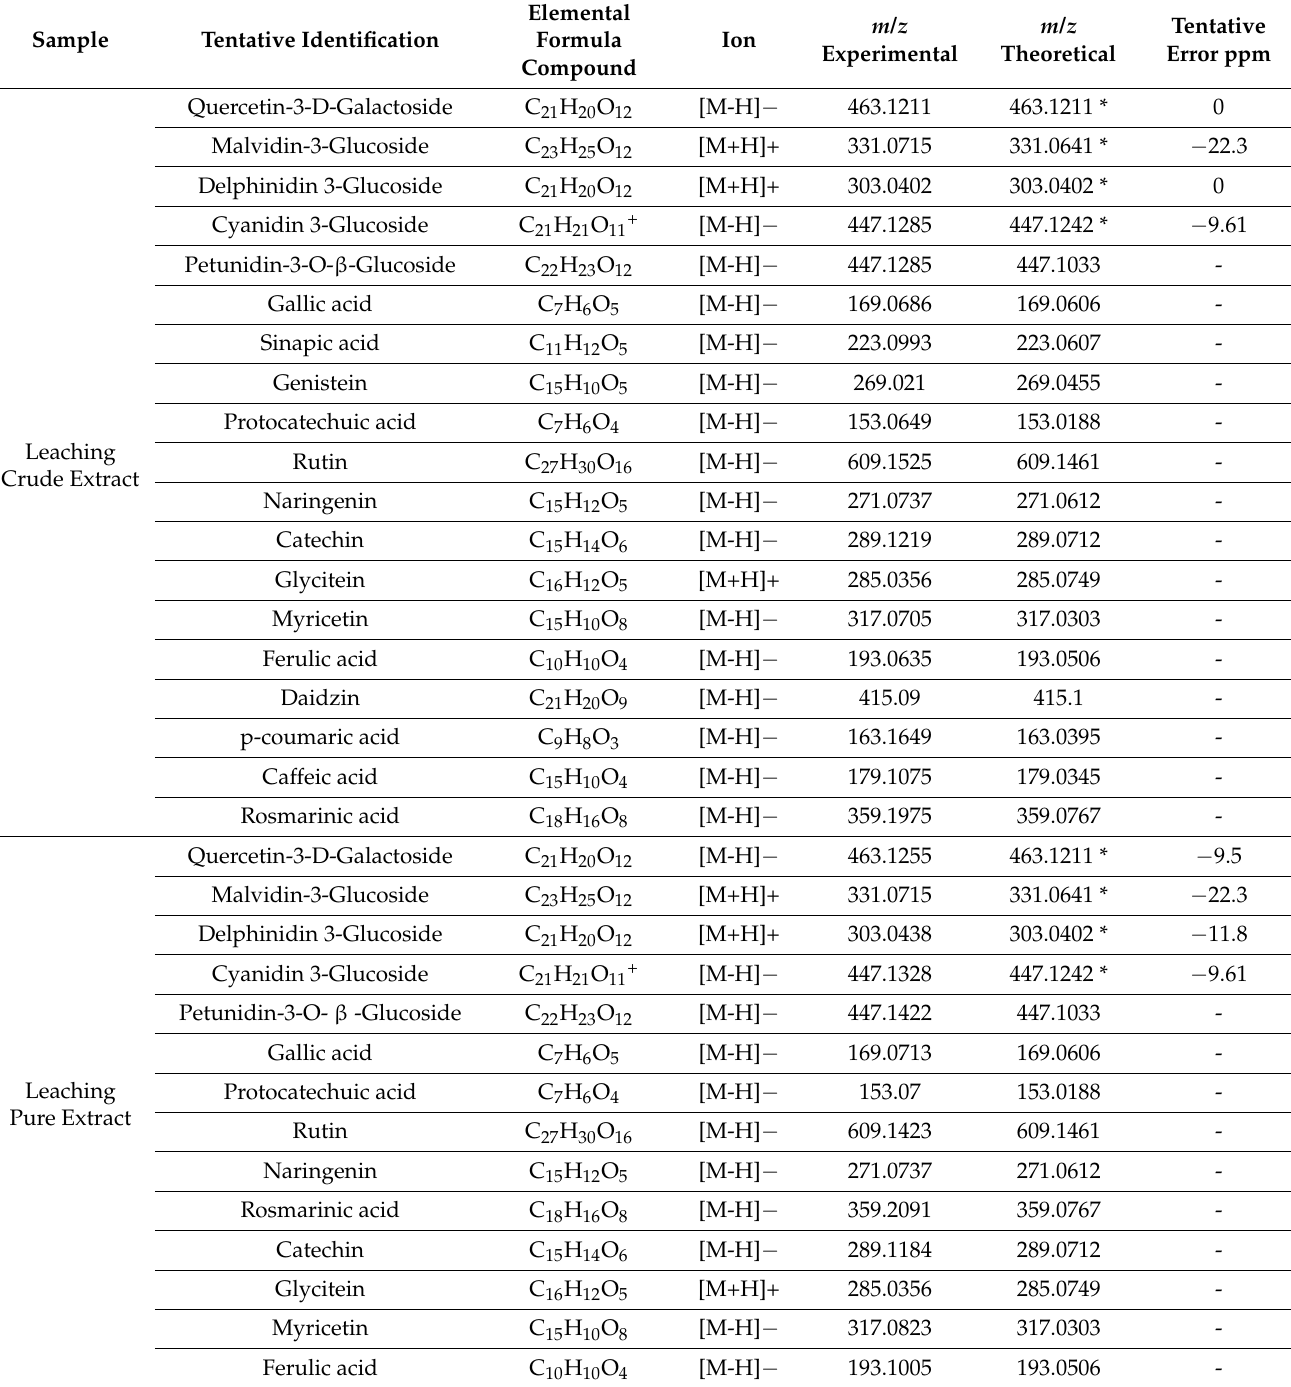
Table 2. Tentative phenolic compounds identified by ESI-QTOF using direct infusion